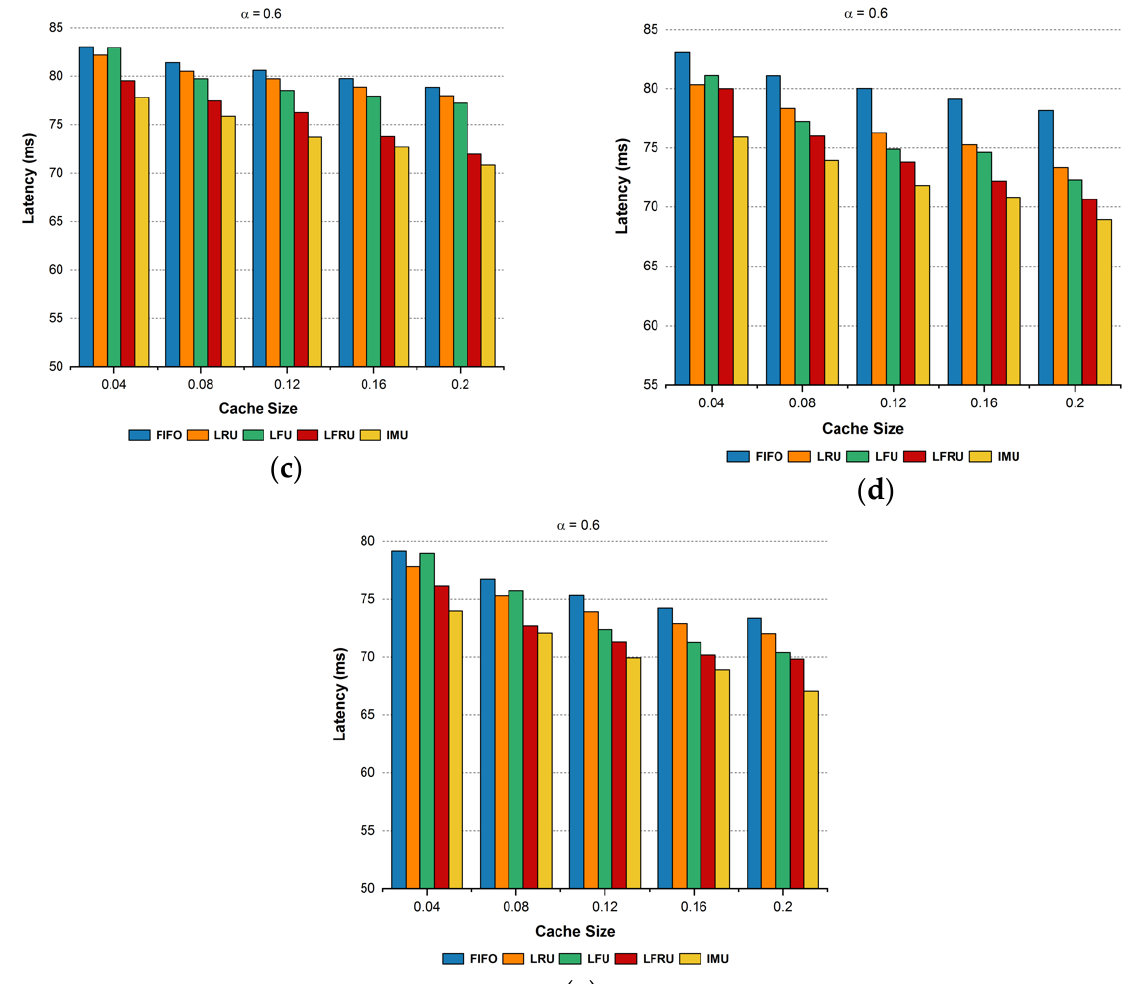
Figure 4. Latency with different cache sizes and α , using different placement policies. ( a ) Latency with LCE. ( b ) Latency with CL4M. ( c ) Latency with ProbCache. ( d ) Latency with LCD. ( e ) Latency with opt-Cache. Table 11. IMU path stretch percentage